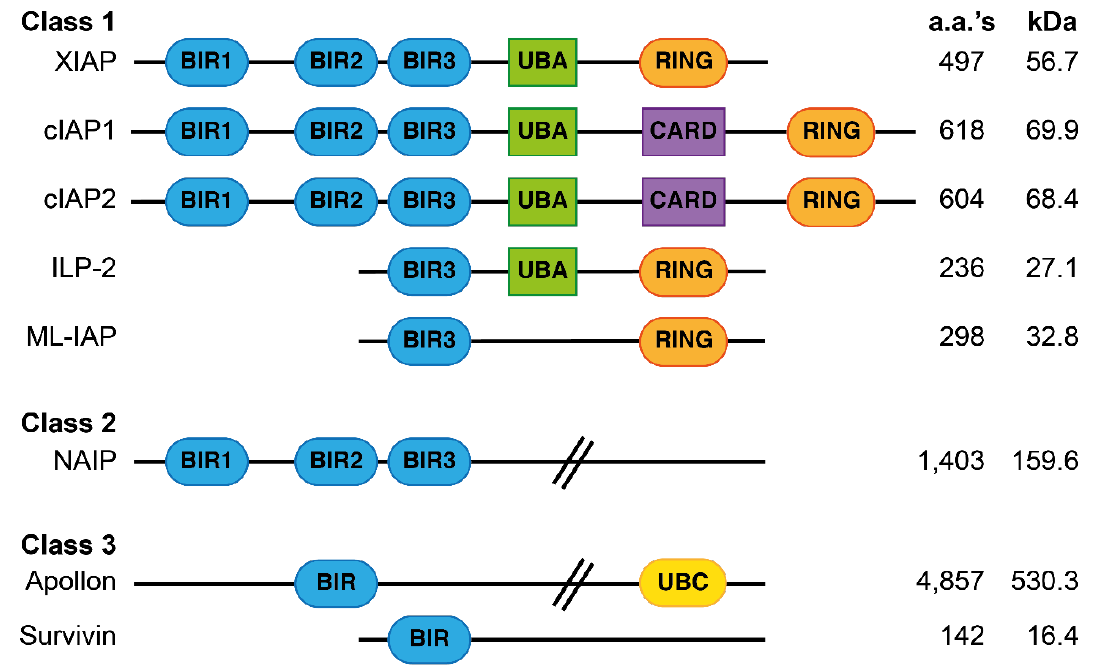
Figure 1. Schematic representation of the structures of the eight-mammalian Inhibitor of APoptosis (IAP) proteins. BIR, Baculovirus IAP repeat domain; UBA, Ubiquitin binding domain; CARD, Caspase recruitment domain; RING, E3-Ligase domain; UBC, E2-Ligase domain; a.a. ’s , amino acids; kDa, kilodalton. The position and size of domains are not represented to